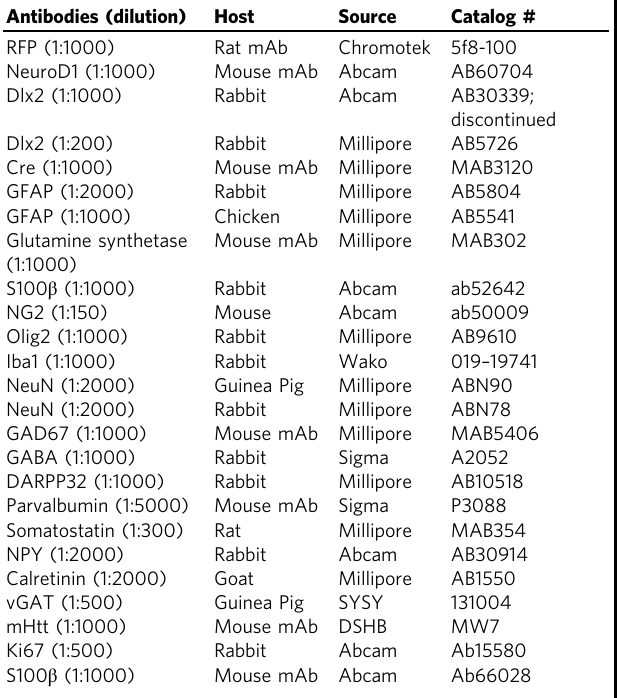
Fig. 8 Functional improvement of the R6/2 mice following in vivo cell conversion. a Representative footprint tracks among wild-type littermates, R6/2 mice, R6/2 mice treated with control viruses or NeuroD1 + Dlx2 viruses. Dashed lines indicate stride length ( L ) and width ( W ). b , c Quanti fi ed data